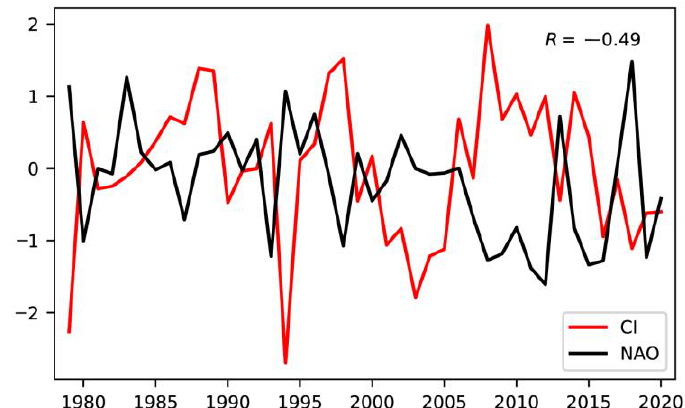
Figure 5. Composite summer surface level pressure anomalies (units: hPa) for ( a ) DR-type and ( b ) DT-type. The surface level pressure anomalies significant at the 90% confidence level are dotted. The black solid lines (from 80° W to 30° E at 35° N and 65° N) indicate the latitudinal band for calculating NAO index.